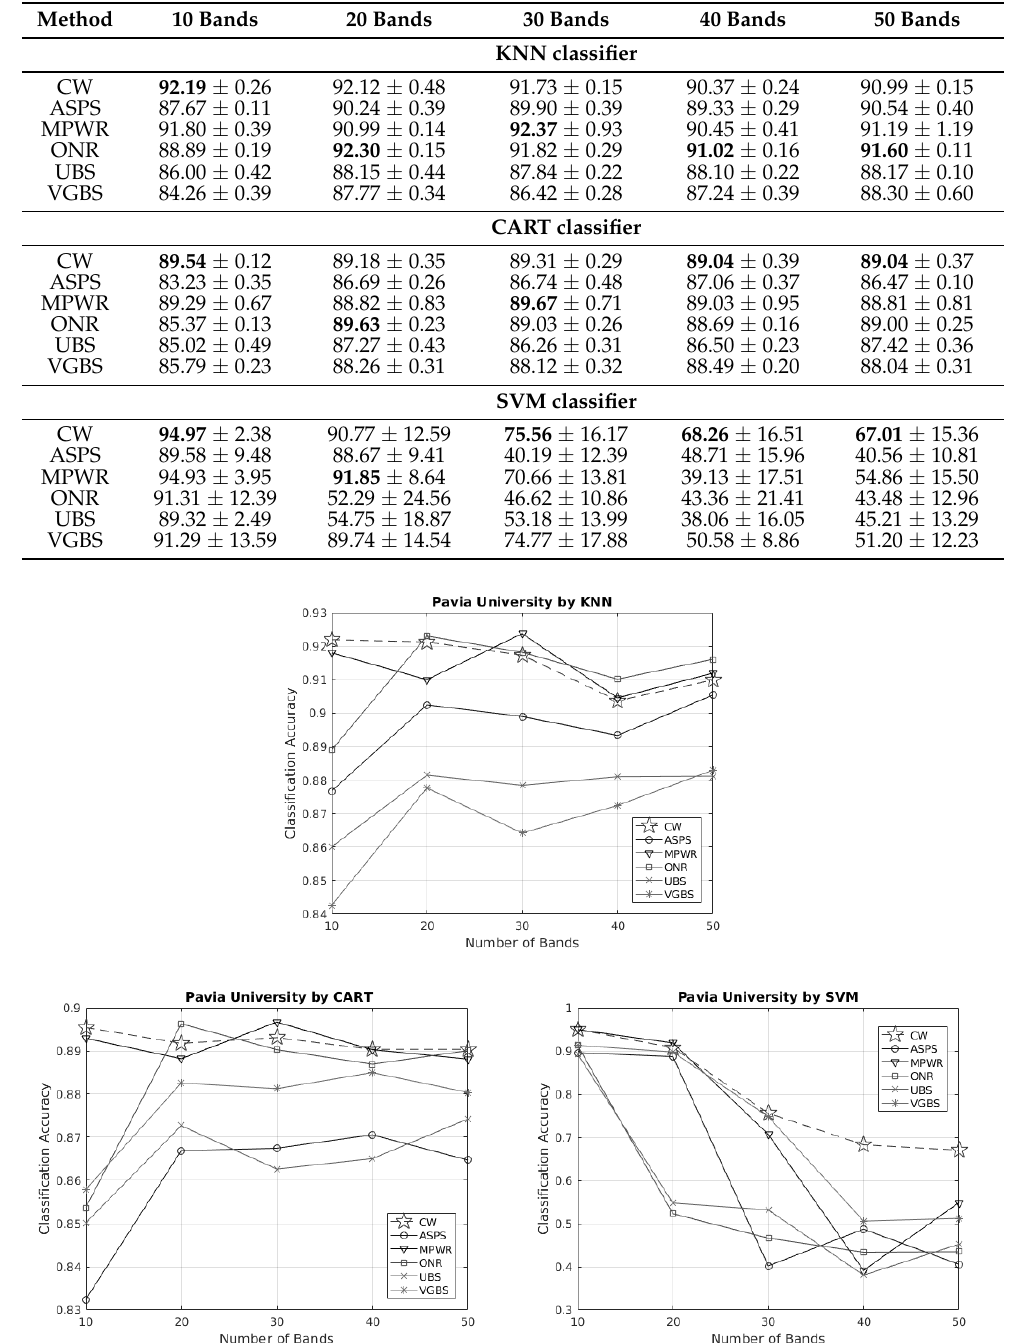
Table 4. Pavia University image results ( overall accuracy and standard deviation in % ).